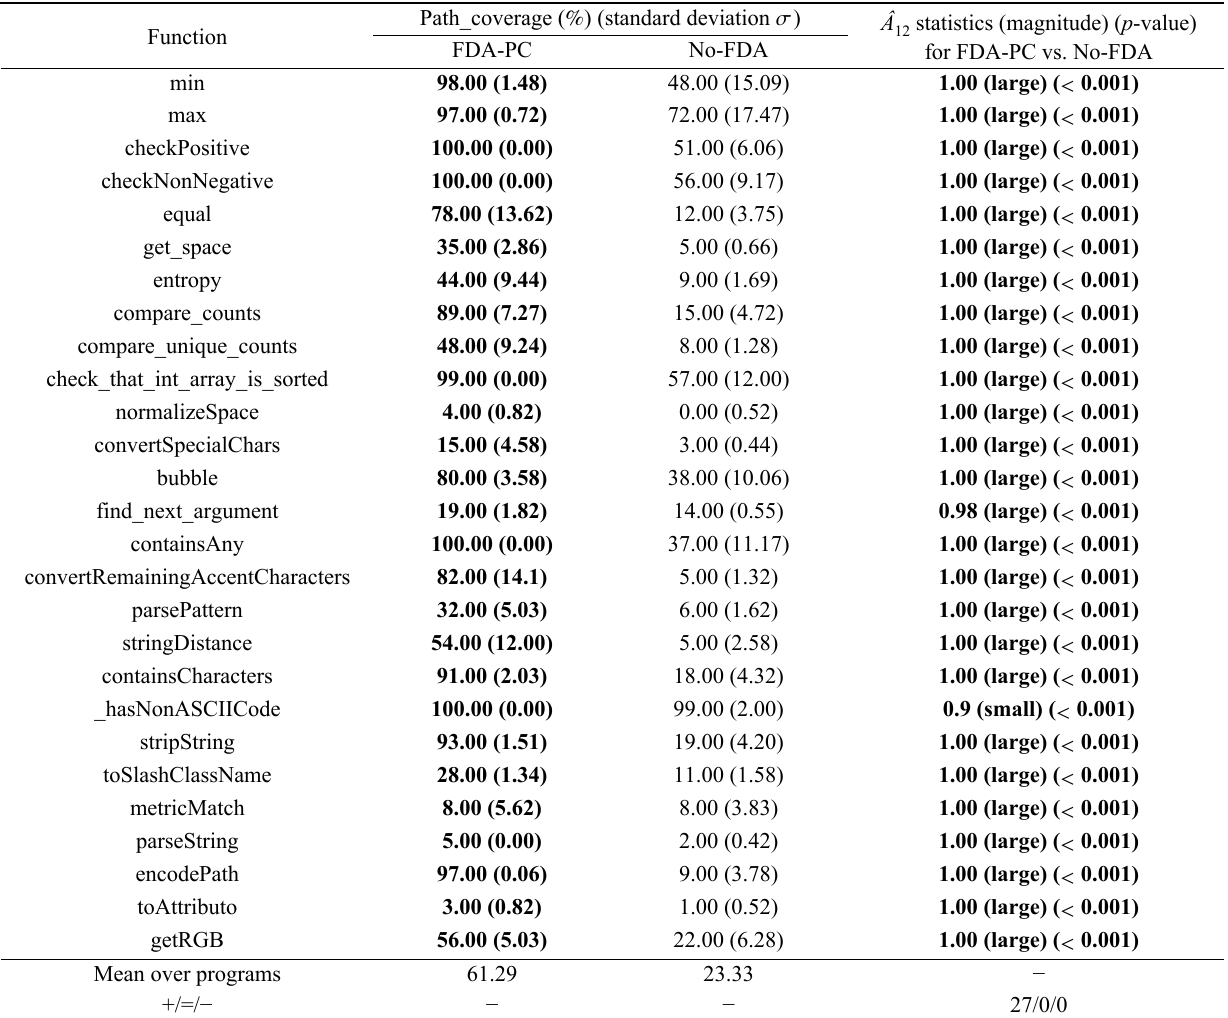
Note: “+” indicates the number of programs where FDA-PC performs better than No-FDA according to the Wilcoxon test. “=” indicates the number of programs where FDA-PC performs equivalently to No-FDA according to the Wilcoxon test. “−” indicates the number of programs where FDA-PC performs better than No-FDA according to the Wilcoxon